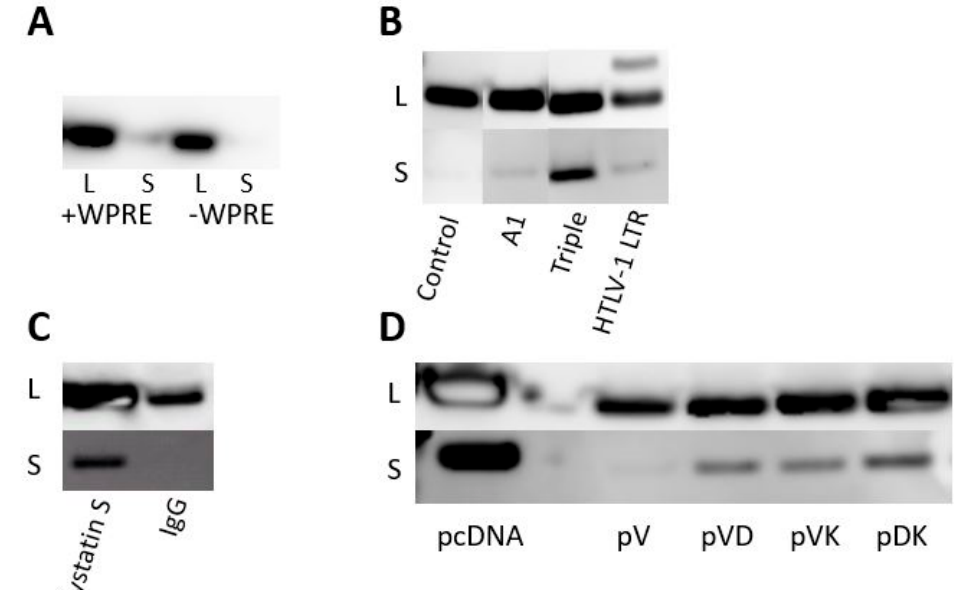
Figure 1. Western blot detection of Core protein in lysate (L) and supernatant (S) of HEK293T cells transfected with plasmids containing different enhancer elements, signal peptides, and